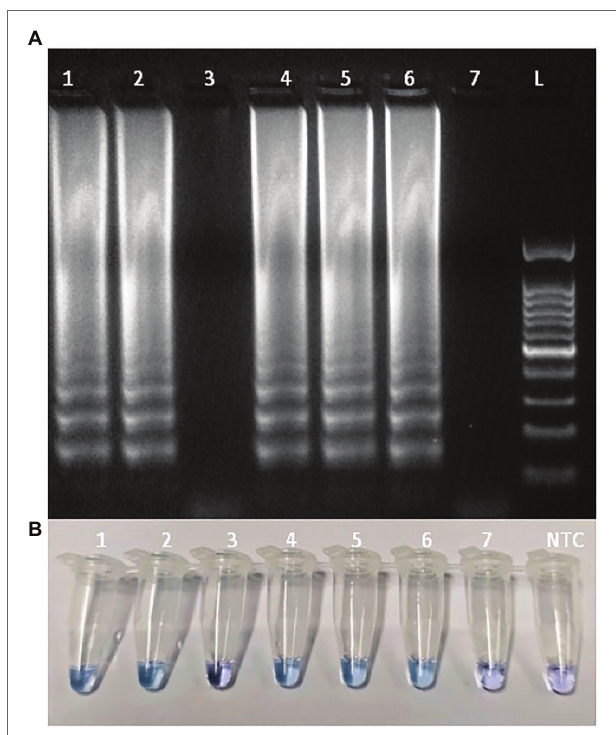
FIGURE 3 | Detection of ToBRFV isolates in tomato leaves samples using loop-mediated isothermal amplification (LAMP) assay: (A) Agarose gel electrophoresis analysis of the LAMP products; (B) Detecting LAMP products by adding hydroxynapthol blue (HNB) as dye. Lane L: 100 bp ladder (GeneSpin); line 1: isolate Sic1/19; line 2: isolate T1101; line 3: ToMV (isolate PC15705); line 4: isolate TBRFV-Ps1; lines 5 and 6: isolate PC-1236; line 7: tomato healthy leaves; NTC: no template